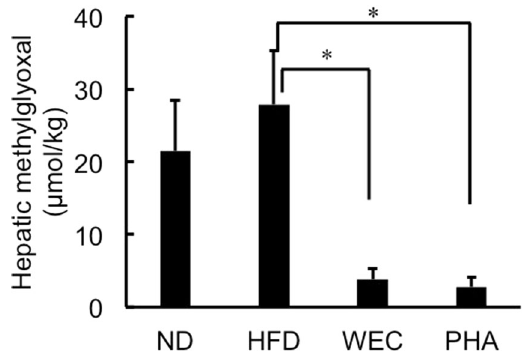
Fig. 4 The effects of WEC and PHA on hepatic methylglyoxal levels. Hepatic methylglyoxal levels in the normal diet-fed (ND), high-fat diet-fed (HFD), Chlorella pyrenoidosa water extract-treated (WEC), and phenethylamine-treated (PHA) groups. Data are repre- sented as mean ± standard deviation ( n = 6). The means were compared using analysis of variance, followed by Dunnett ’ s test. * p < 0.05 vs. HFD